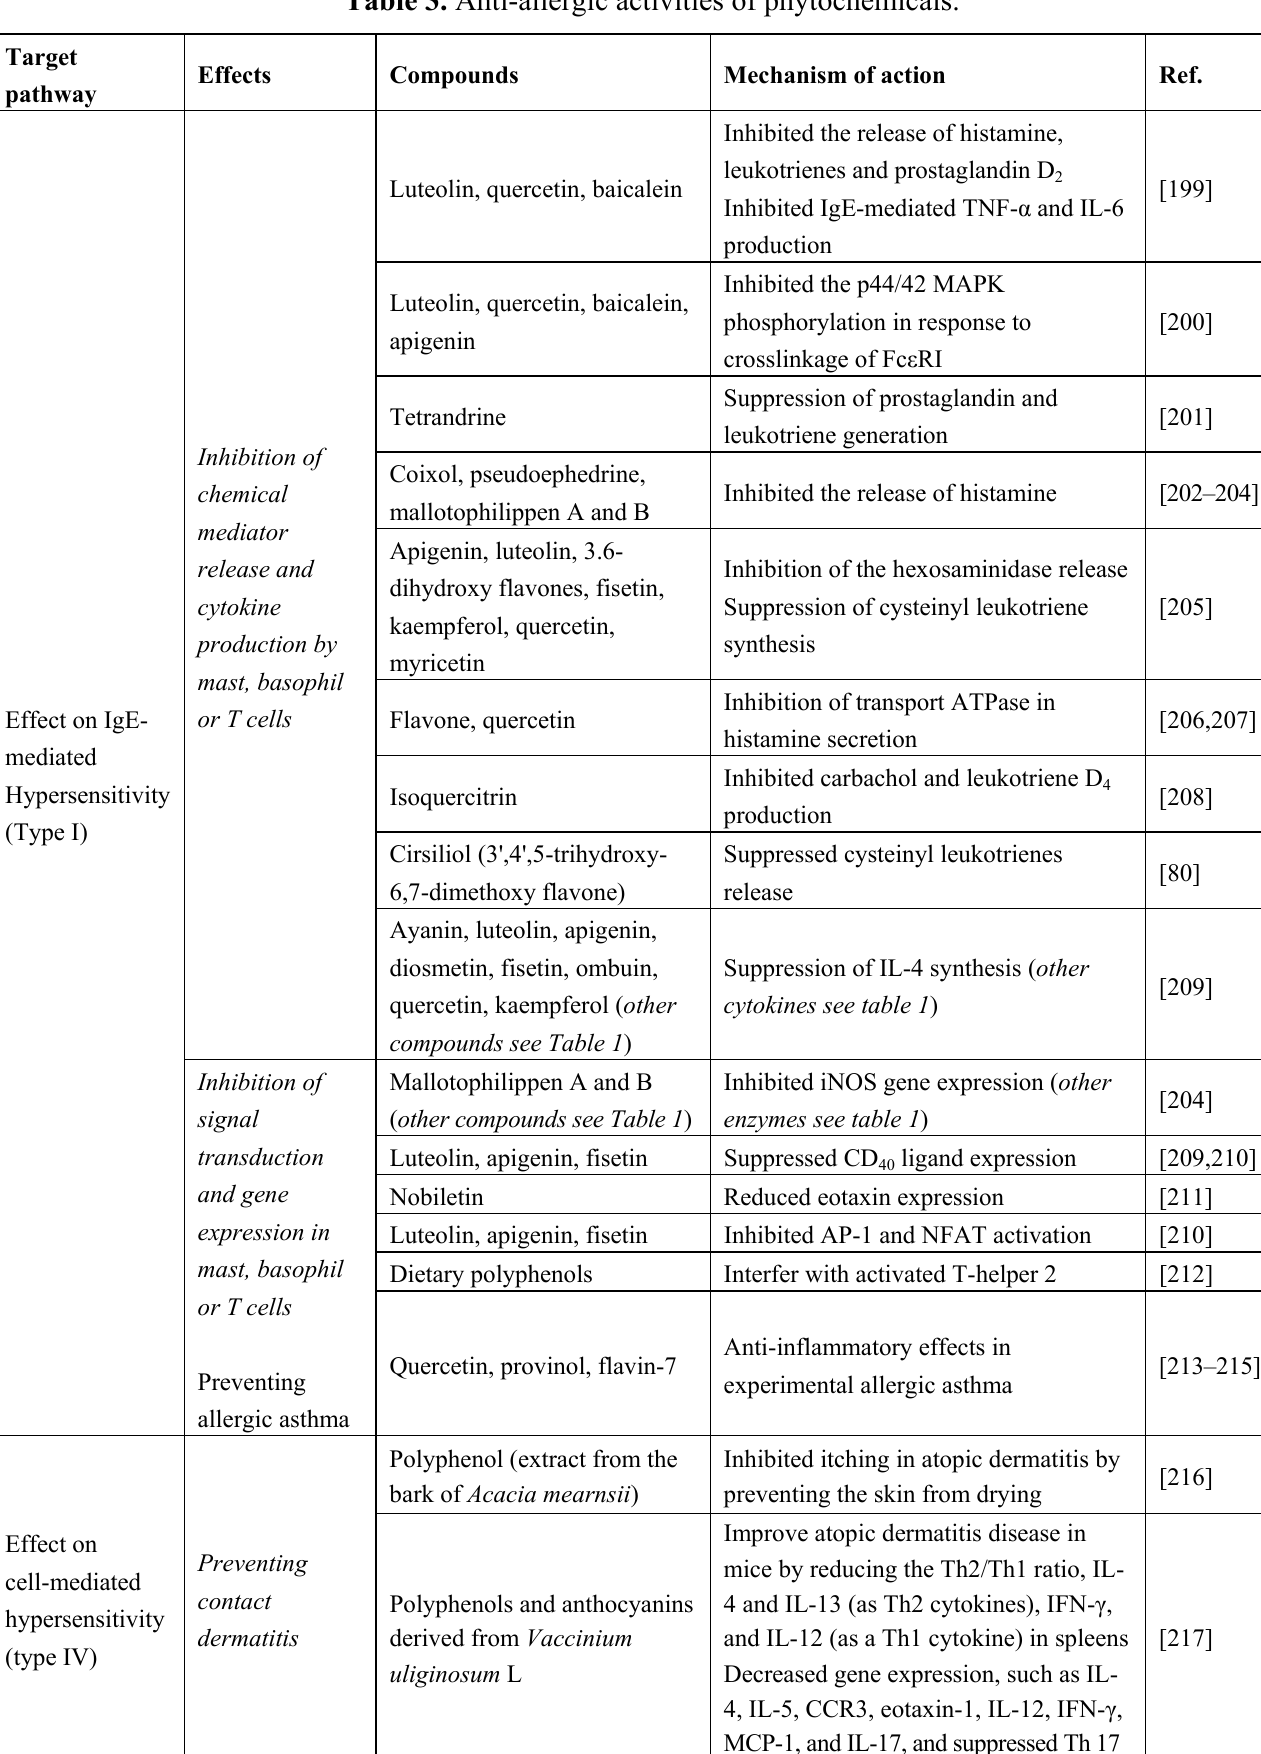
Table 3. Anti-allergic activities of